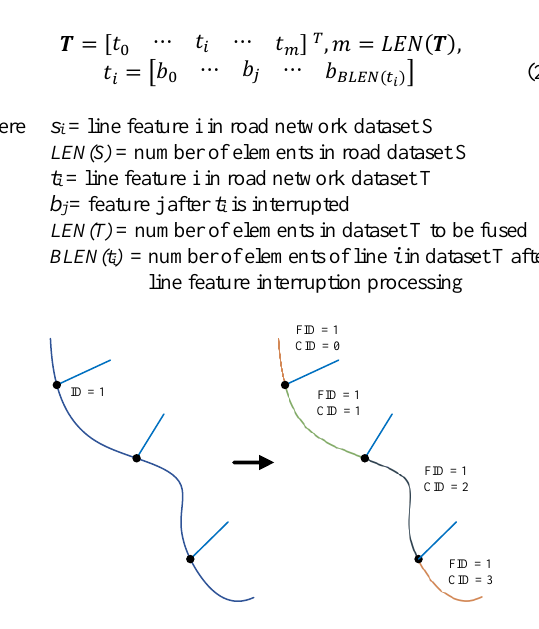
Figure 2 . Road feature divided into four sub